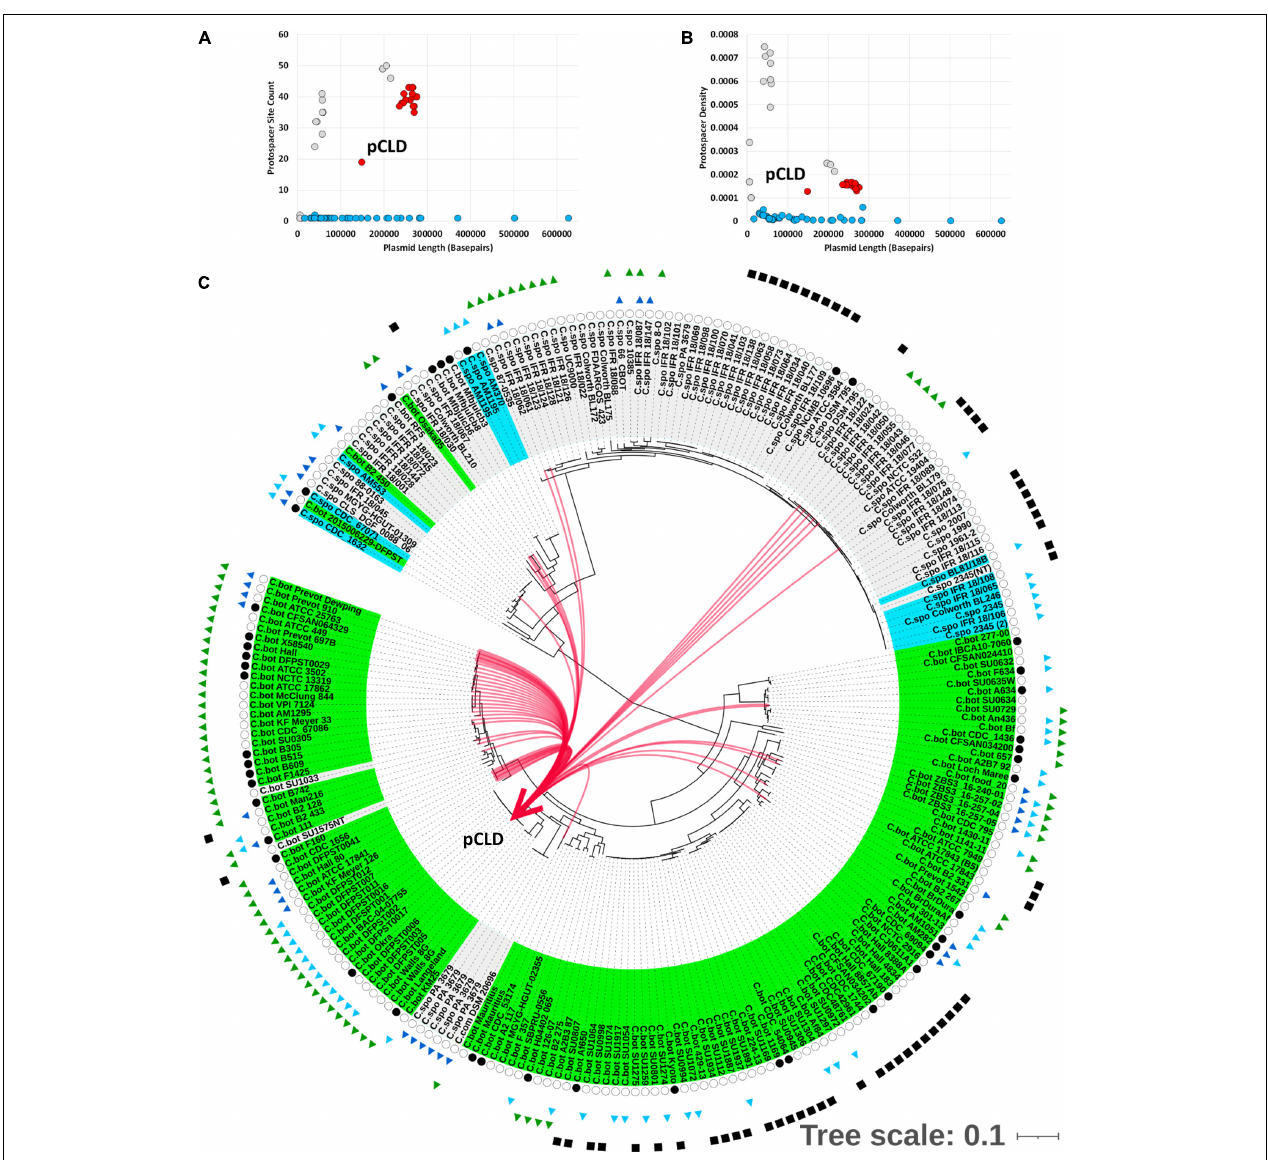
FIGURE 4 | bont (+) conjugative plasmids targeted by CRISPR-Cas systems in G1 C. botulinum and C. sporogenes . (A) Plasmid length ( x -axis) by number of (redundant) spacer–protospacer (Sp-PS) matches ( y -axis) for Refseq plasmids; BoNT(+) plasmids in red, bont( − ) plasmids from C. sporogenes and G1. C. botulinum in gray, matches to plasmids from other species in blue. (B) Transformation of (A) to plasmid length ( x -axis) by Protospacer Density (Sp-PS matches/plasmid length) ( y -axis) by plasmid length. (C) Visual representation of matched spacer containing assemblies to plasmid pCLD.